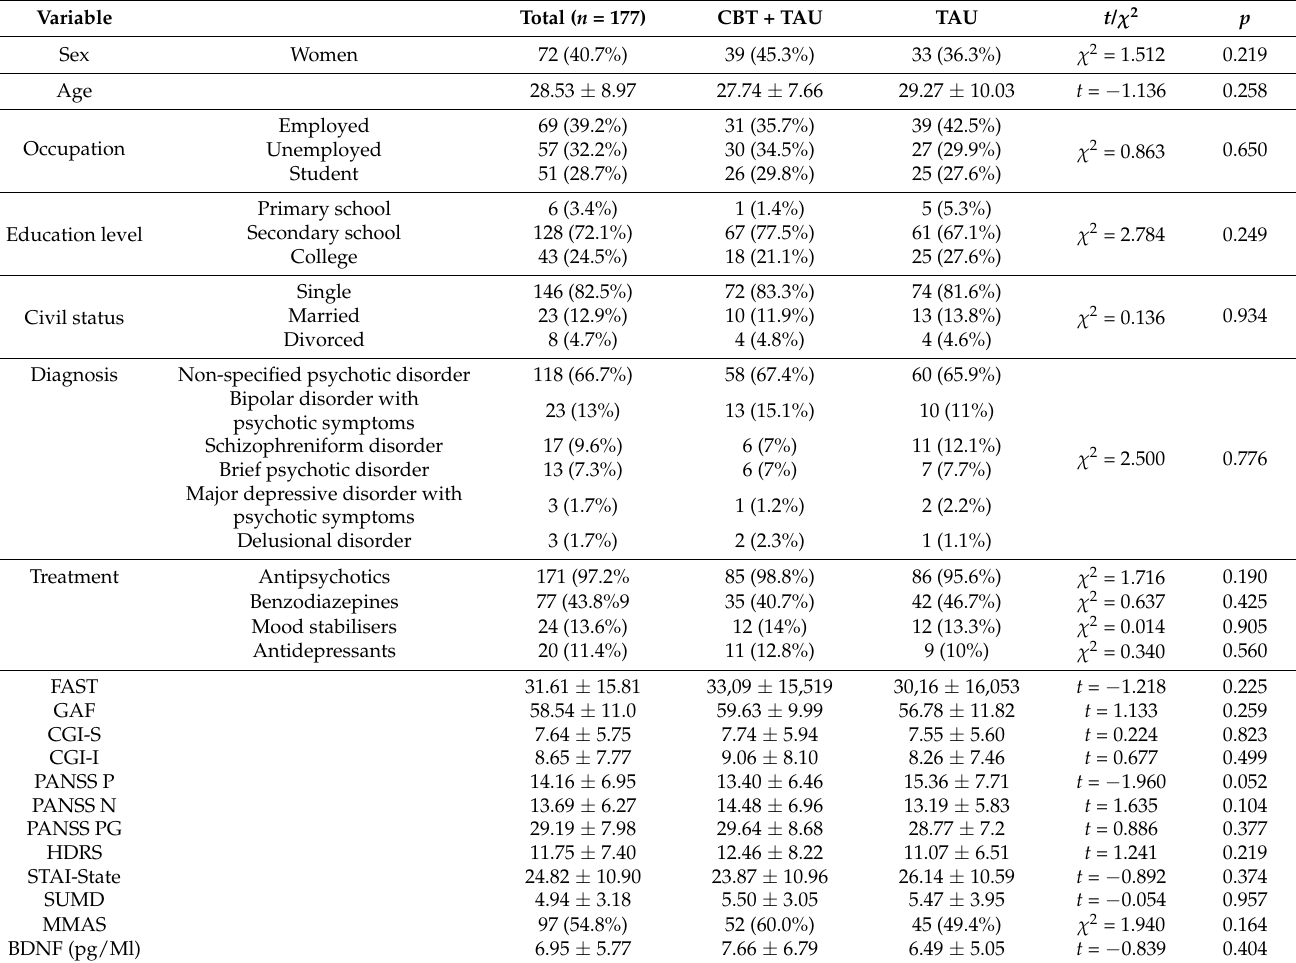
Table 1. Baseline sociodemographic and clinical characteristics of the sample.